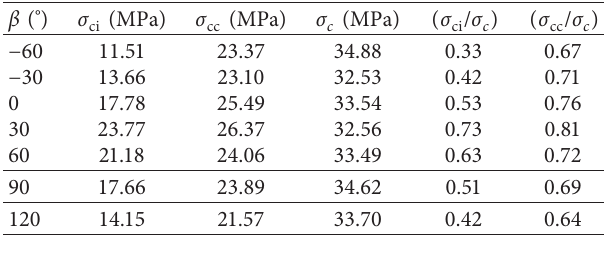
Table 5: The crack initiation and coalescence stresses ( ( σ ( σ / σ c ) ) for different dips of the rock bridge with main flaw ( c ). cc